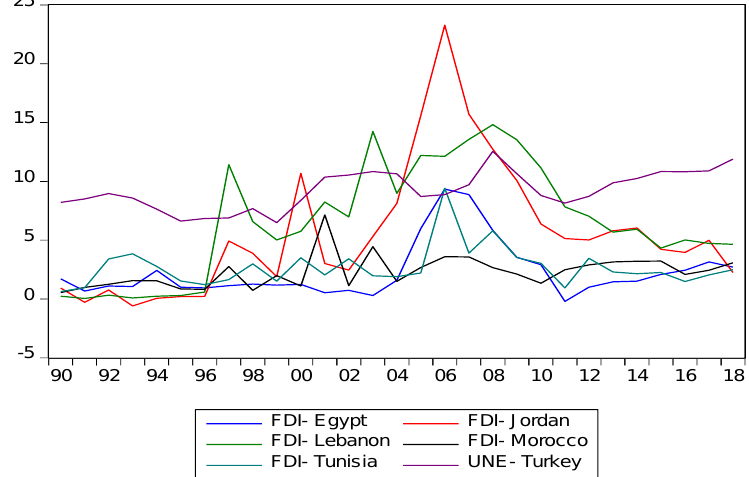
Figure 1. The evolution of foreign direct investments in the six analyzed